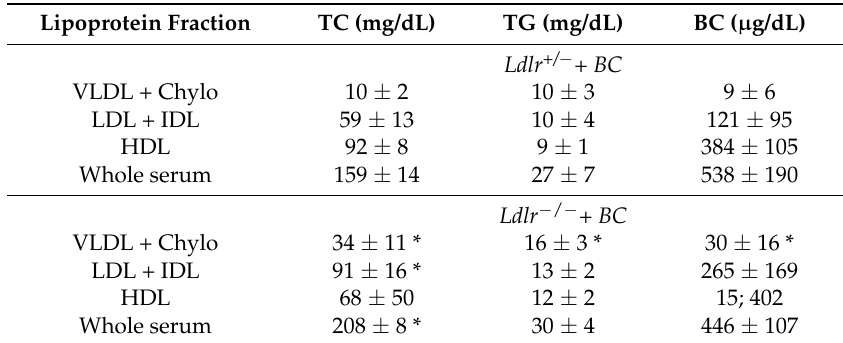
Table 1. Maternal plasma lipoprotein lipid and β -carotene concentrations in Ldlr +/ − and Ldlr − / − pregnant dams supplemented with β -carotene.